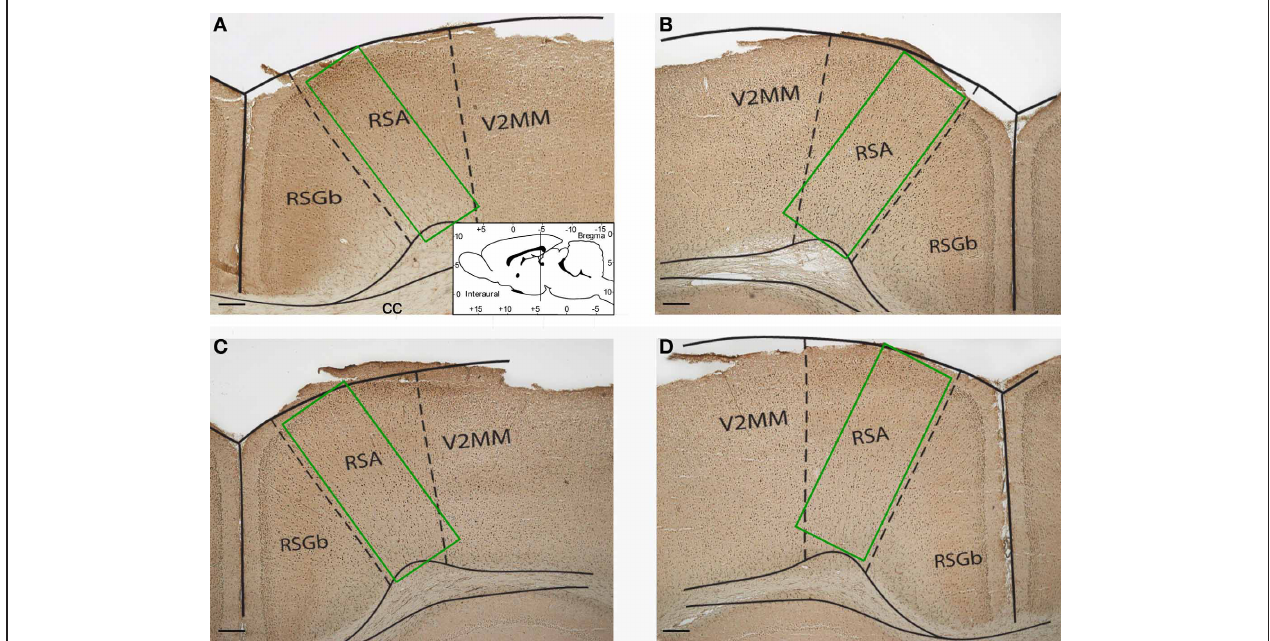
FIGURE 1 | Representative photomicrographs showing sample areas of the retrosplenial cortex of control (A), “1 stage” (B), “5 stages” (C), and “9 stages” (D) group animals. Coronal sections of 20 μ m thickness. Scale corpus callosum.